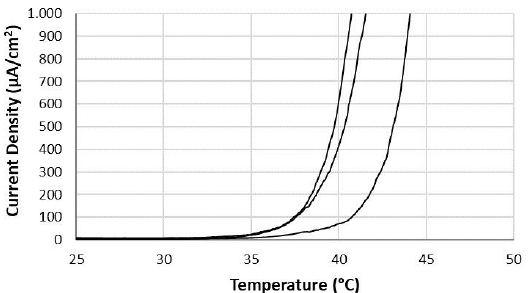
Figure 5. CPTs obtained for UNS S32205 samples.